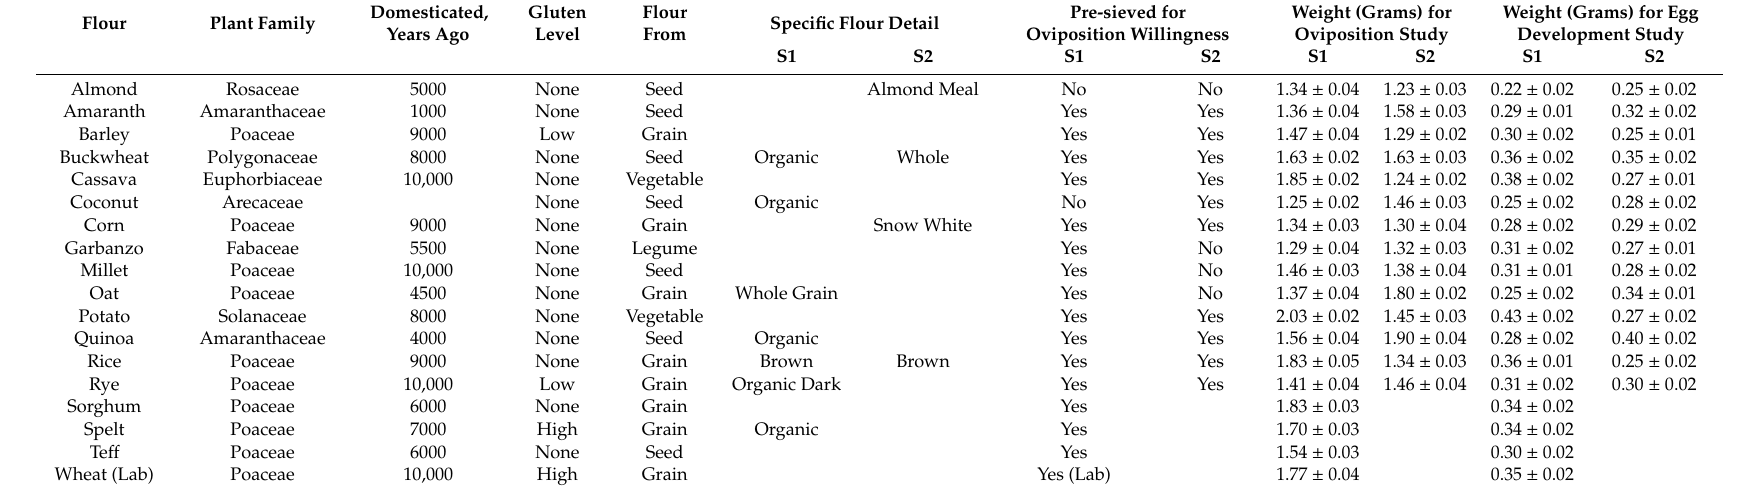
Table 1. Information about flours. Weights are reported in grams, with mean ± standard error. S1 is Source 1 and S2 is Source